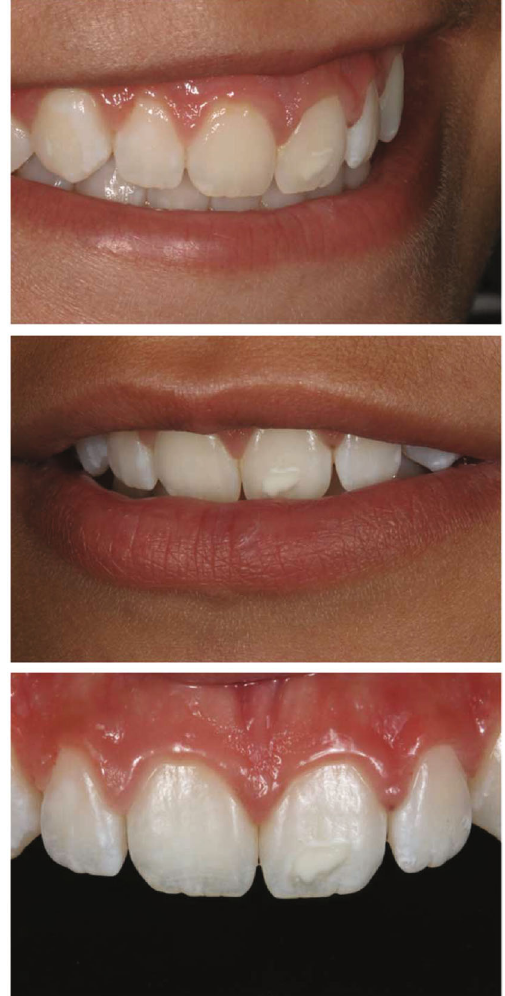
Figure 1: Initial smile and upper anterior teeth. Note the hypoplasia spots on the incisal third of the upper central incisors in the form of streaks and hypoplasia opaque white spot on the upper left central incisor.